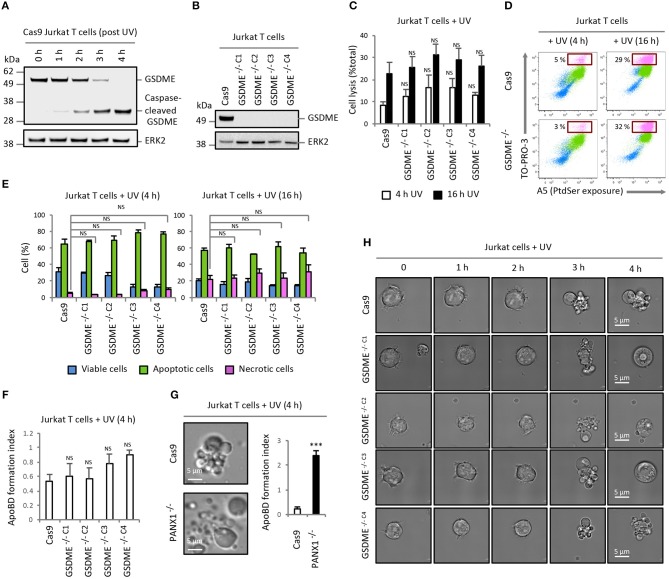
Loss of GSDME does not affect the level of secondary necrosis and ApoBD formation in Jurkat T cells. (A) Expression of GSDME and proteolytic processing of GSDME during UV-induced apoptosis (150 mJ/cm2) in Cas9 Jurkat T cells. (B) Loss of GSDME protein expression with CRISPR/Cas9-mediated GSDME gene disruption in Jurkat T cell clonal populations. GSDME expression in (A,B) were detected using immunoblotting analysis. (C) Levels of cell lysis in Cas9 control and GSDME−/− Jurkat T cells treated with UV irradiation was quantified based on the release of LDH into the culture supernatant (n = 3). (D) Representative flow cytometry plots of viable, apoptotic and necrotic cells generated by Cas9 control and GSDME−/− Jurkat T cells treated with UV irradiation to induce apoptosis. (E) Levels of viable, apoptotic and necrotic cells in Cas9 control and GSDME−/− Jurkat T cells treated with UV irradiation to induce apoptosis was determined by flow cytometry (n = 3). (F) Formation of ApoBDs from apoptotic Cas9 control and GSDME−/− Jurkat T cells (n = 3). ApoBD formation index determined by the number of ApoBDs divided by the number of A5+ apoptotic cells. (G) Disassembly of apoptotic Cas9 and PANX1−/− Jurkat T cells was monitored by live DIC microscopy and flow cytometry (n = 3). (H) Live DIC microscopy images monitoring morphologies of UV-irradiated Cas9 control and GSDME−/− Jurkat T cells over 4 h. Error bars represent s.e.m. Data are representative of at least two independent experiments. P-values were determined by directly comparing a GSDME−/− clone to Cas9 control at that particular timepoint, using One-way ANOVA post-hoc using Turkey's test in (C,E,F) or unpaired Student's two-tailed t-test in (G). ***P < 0.001, NS = P > 0.05.